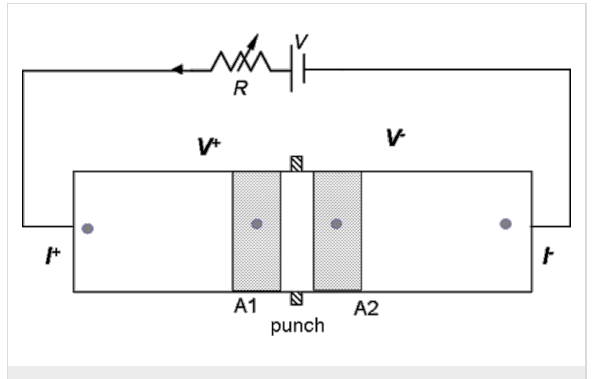
Figure 4: Sketch of the top view of the sample; A1, A2 are the (10 × 10 mm) areas on the sample monitored by the infrared camera during the bending tests. The positions of the voltage ( V + , V − ) and cur- rent ( I + , I − ) probes are indicated.